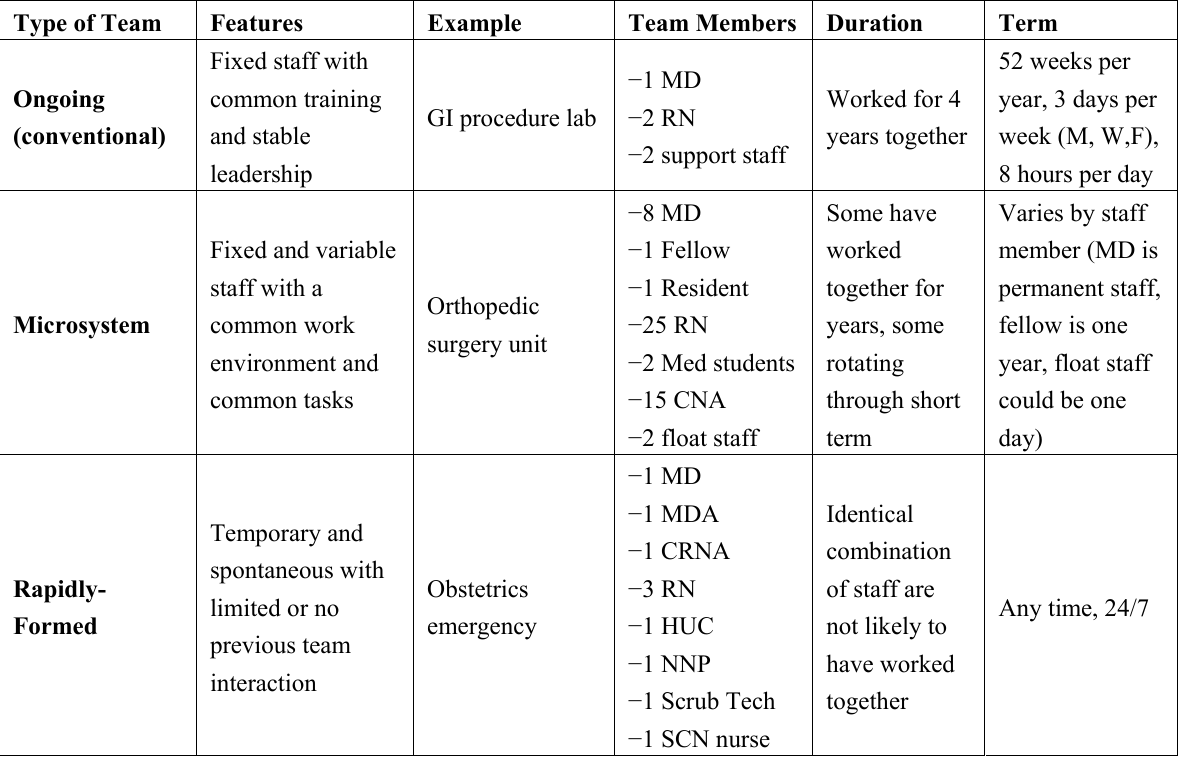
Table 1. Taxonomy of clinical healthcare